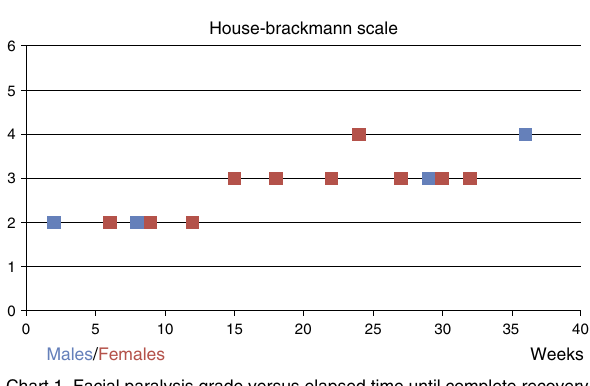
Figure 1 Facial paralysis grade versus elapsed time until com- plete recovery.